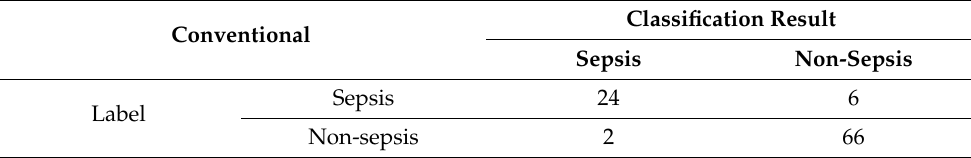
Table 6. Confusion matrix of Caltech-101. Classification accuracy achieved 91.8%